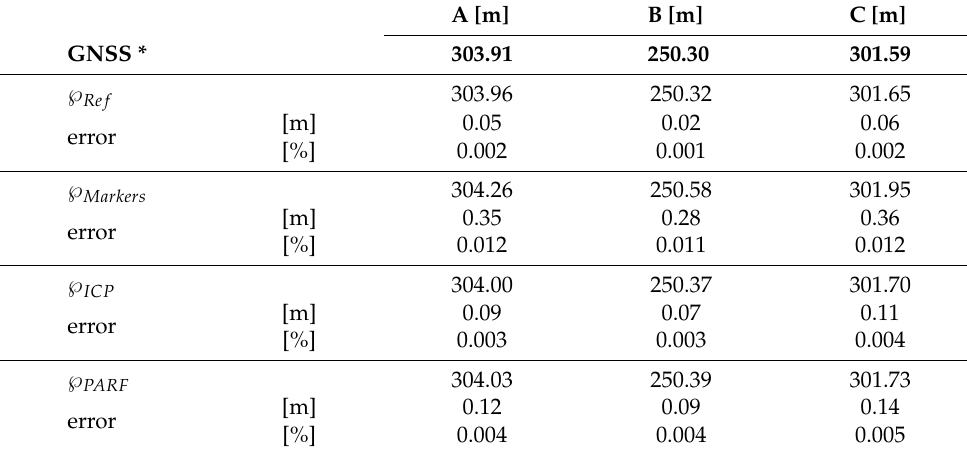
Table 8. Measured distances (cf. Figure 10) in ℘ Ref , ℘ Markers and ℘ PARF point clouds. ∗ The obtained GNSS distance is calculated starting from the GNSS position in NRTK mode with σ : 0.02–0.03 m.